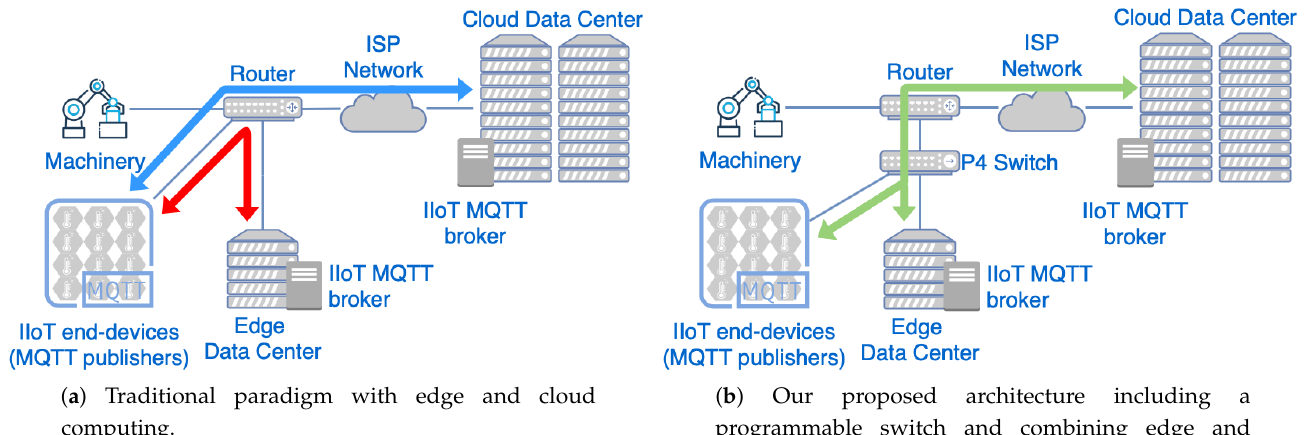
Figure 4. Comparison of edge/cloud computing architectures against our proposed solution including the programmable network element. ( a ) Edge/cloud computing architecture. ( b ) Proposed